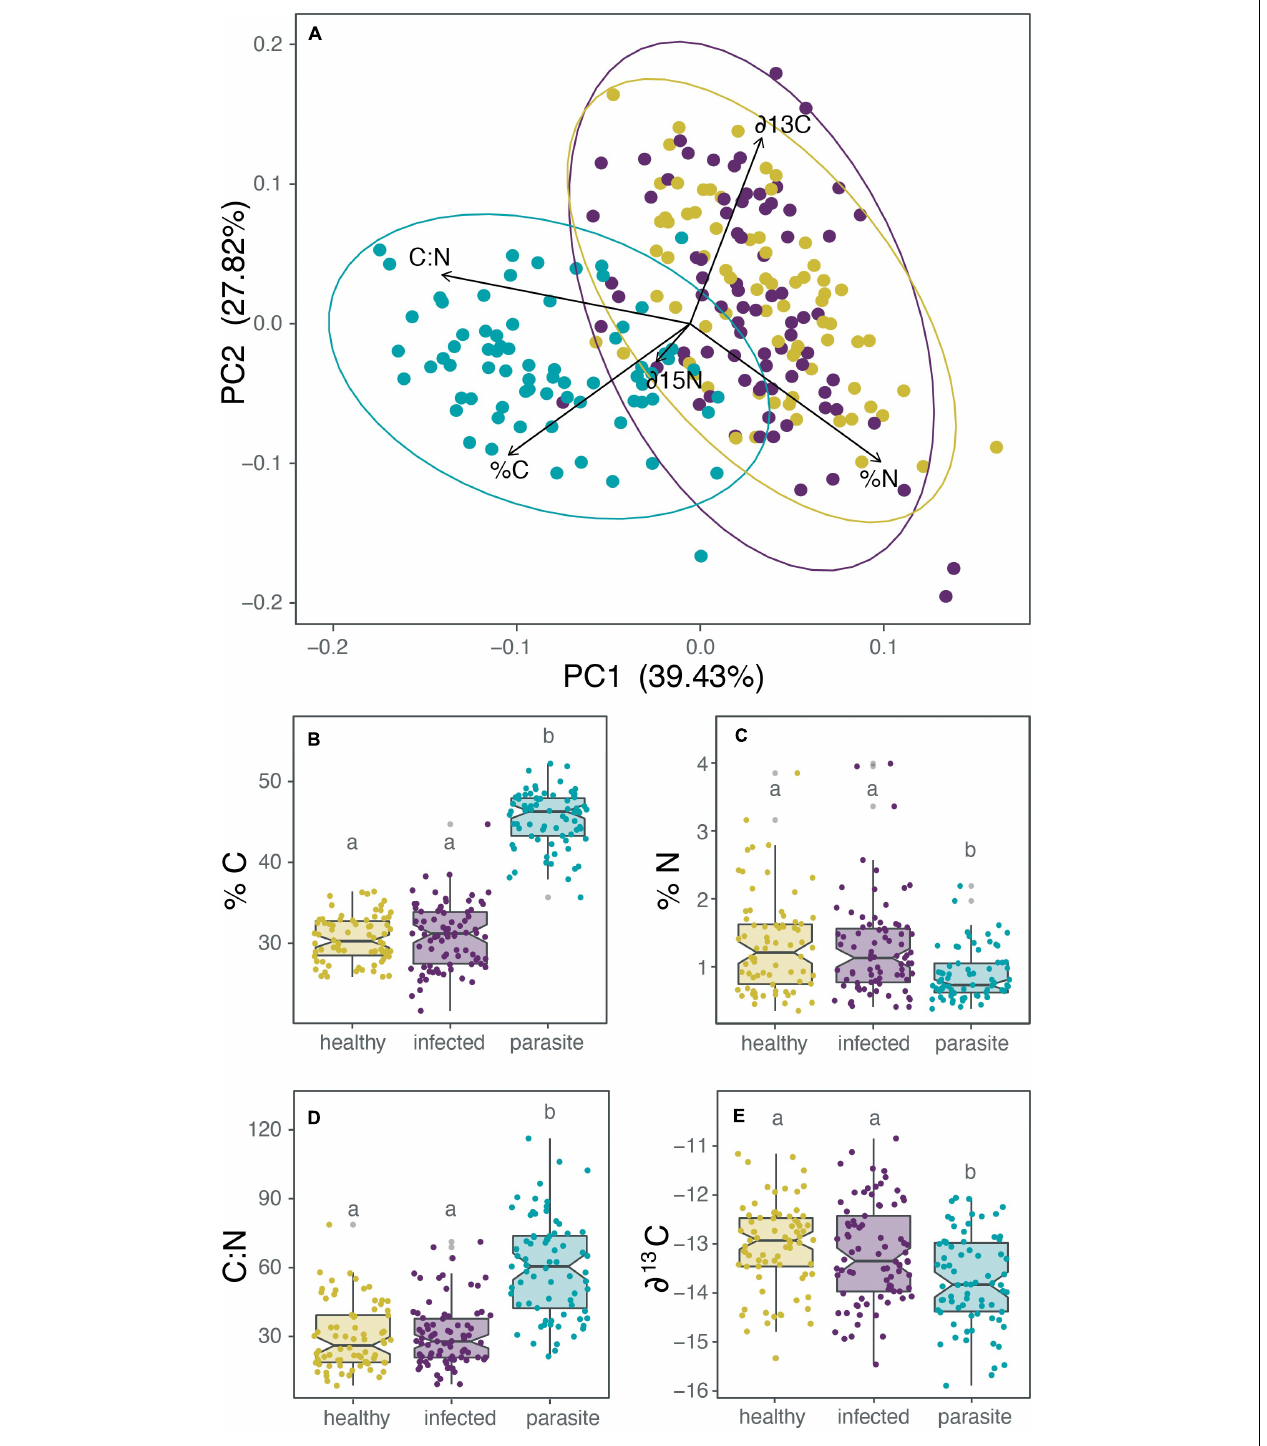
FIGURE 4 | A comparison of the nutrient and isotopic composition between the holoparasite Tristerix aphyllus (green) and its host Echinopsis chiloensis . In all cases E. chiloensis is separated between healthy (yellow) and infected (violet) cacti. (A) PCA of nutrients and isotopes, (B) boxplot of carbon concentration in the tissue (%C), (C) nitrogen concentration in the tissue (%N), (D) C:N ratio in the tissue, and (E) the isotope ∂ 13 C in the tissue. The results for the isotope ∂ 15 N are not shown because there were no differences between the parasite, healthy and infected cacti. Separated ANOVAs were performed for each isotopic or nutrient composition variable. Subsequently a posteriori Tukey HSD analysis confirmed that all healthy and infected cactus were the same (marked with a), and only the parasite (b) significantly differed ( p < 0.001 for all cases).